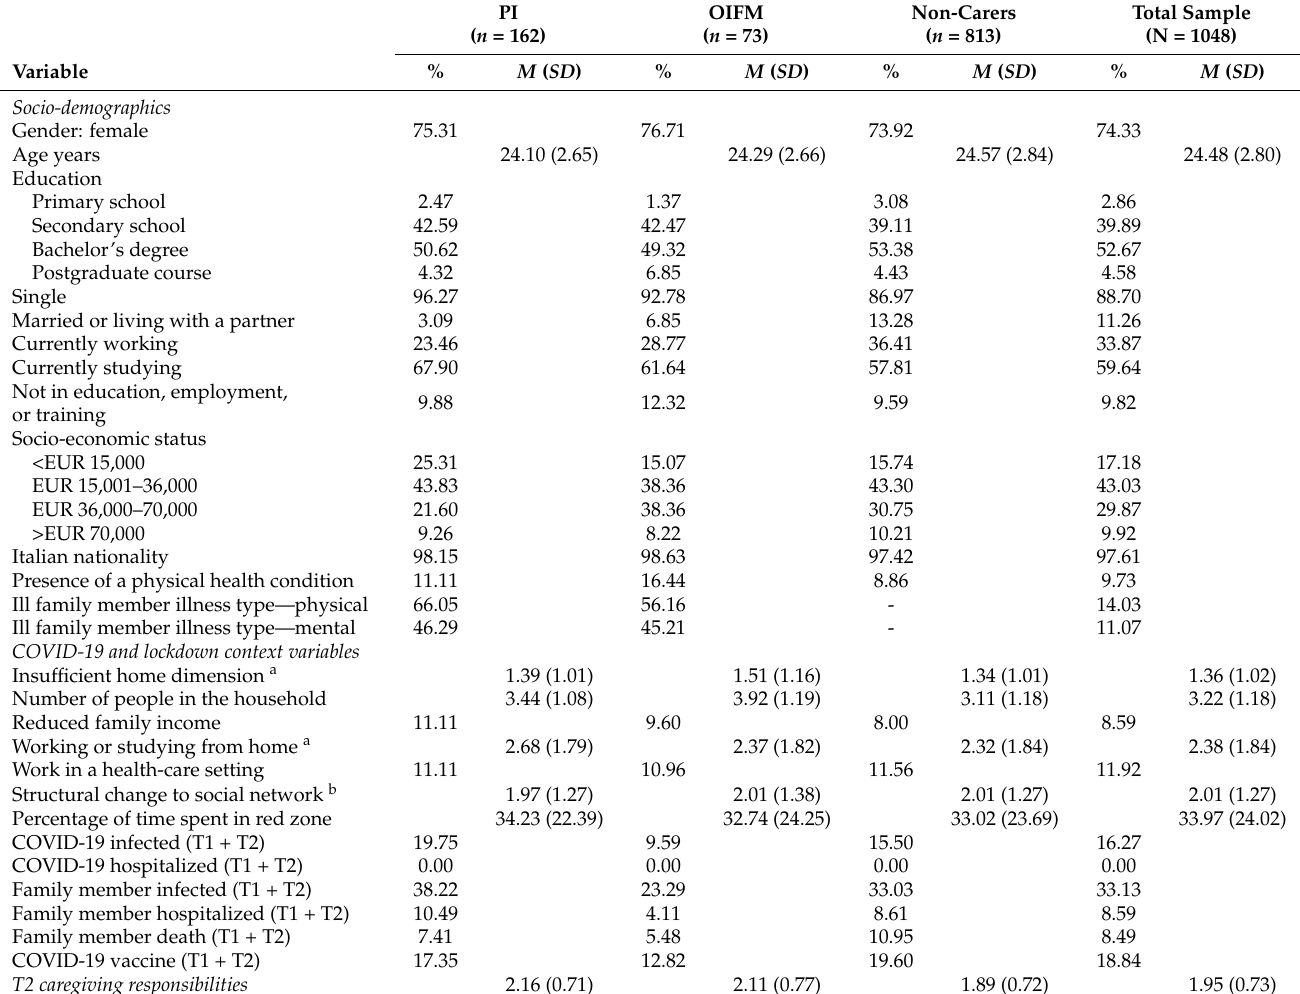
Table 1. Descriptive Data on Time 1 Socio-demographics, Times 1 and 2 COVID-19 Context Variables, and T2 Caregiving Responsibilities in the Parental Illness (PI), Other Ill Family Member (OIFM), and Non-carer